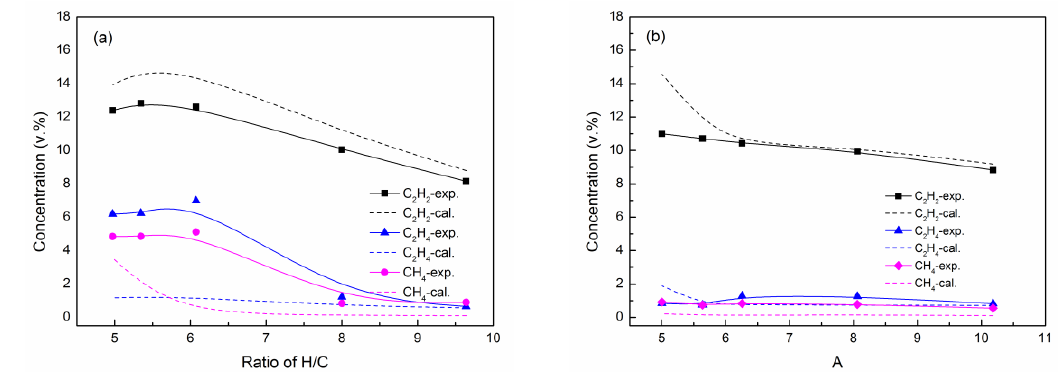
Figure 2. The effect of H/C mole ratio on the concentration of C 2 H 2 , C 2 H 4 and CH 4 in the pyrolysis product of n- hexane ( a ) and toluene ( b ), exp.: experimental data, cal.: calculated kinetic data. Reaction conditions: Q H 2 = 5.0 Nm 3 /h, I = 80 A, P = 14.5 kW, B = 0.058 T, m- n- hexane = 15.0–42.0 g/min, m-toluene = 10.0–25.0 g/min.